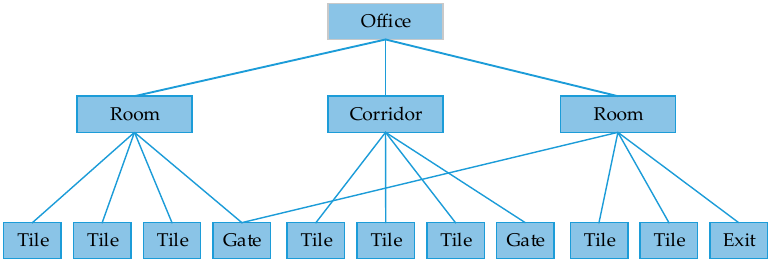
Figure 2. Hierarchy of entities in an office.